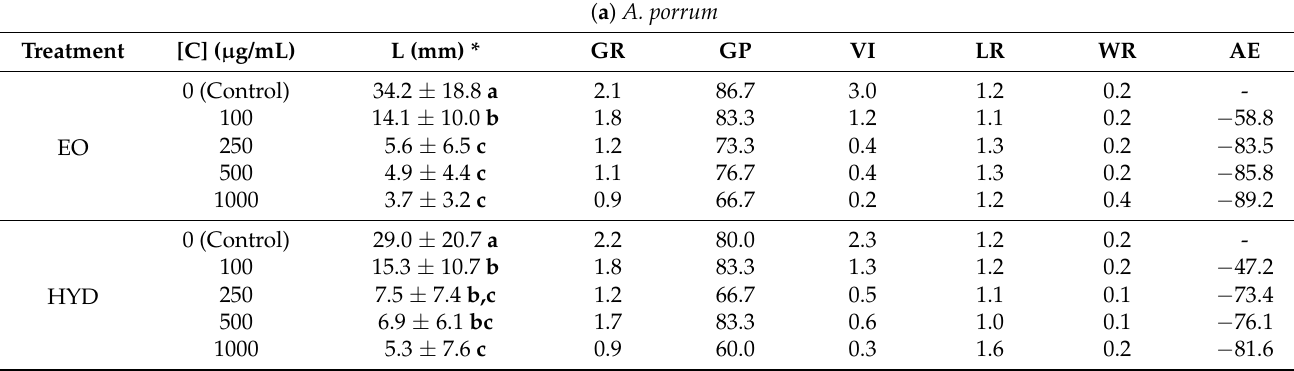
Table 3. Allelopathic effect of X. spinosum root extracts on ( a ) Allium porrum (monocot plant) and ( b ) Raphanus sativus (dicot